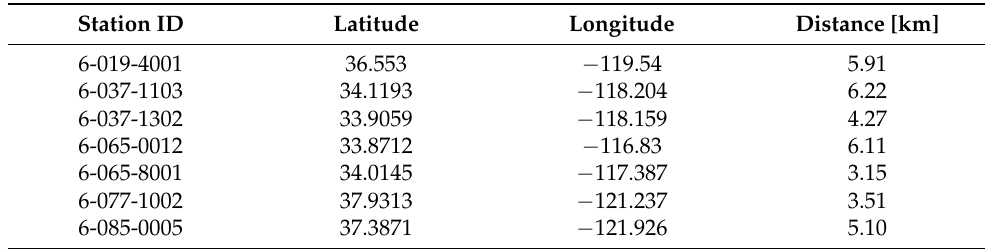
Table 2. Geographical information of the selected grid point for the NAM model corresponding to each ozone monitoring